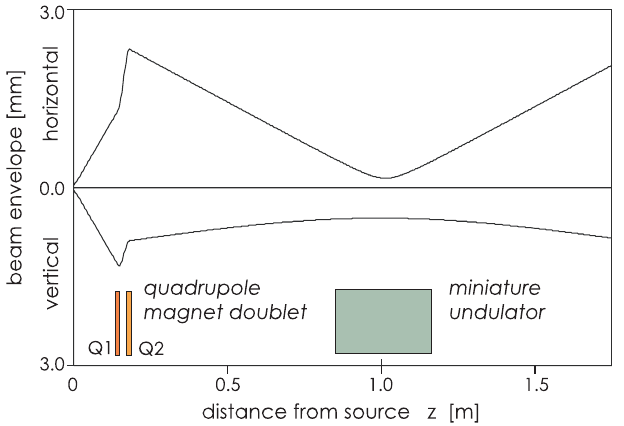
FIG. 1. (Color) Development of the horizontal (upper curve) and vertical (lower curve) beam envelopes of a 150 MeV laser- accelerated electron beam. The beam originates from a source of radius 1 : 3 (cid:1) m ( z (cid:1) 0 ) at an exaggerated maximum diver- gence angle of 8 mrad. It enters a focusing quadrupole doublet (field gradient 500 T = m , individual lengths of the magnets (cid:1) 17 mm and L (cid:1) 15 mm ) and is focused into the min- L Q 1 Q 2 (cid:1) 300 mm iature undulator ( L u